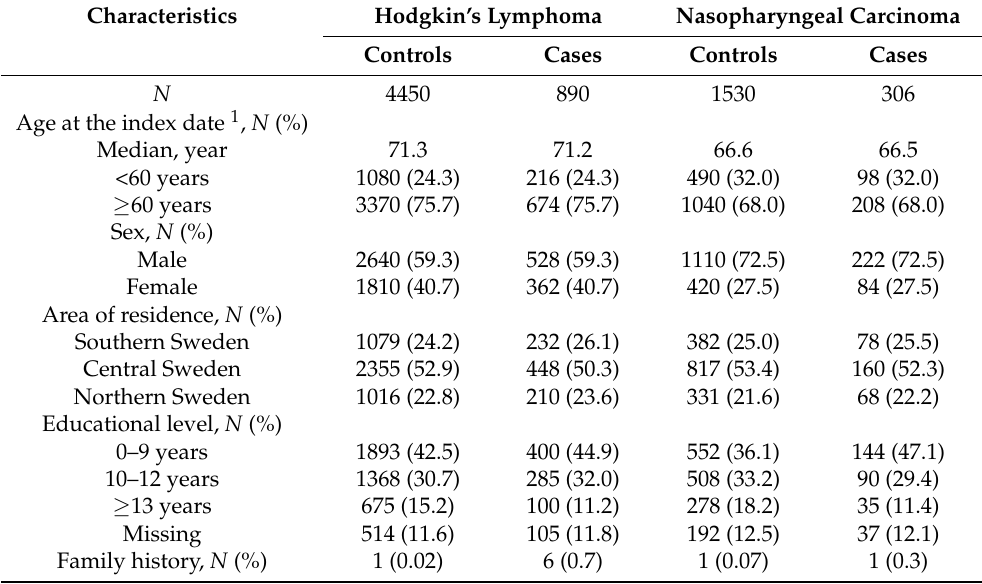
Table 1. Baseline characteristics of patients with EBV-related malignancies and their matched controls.